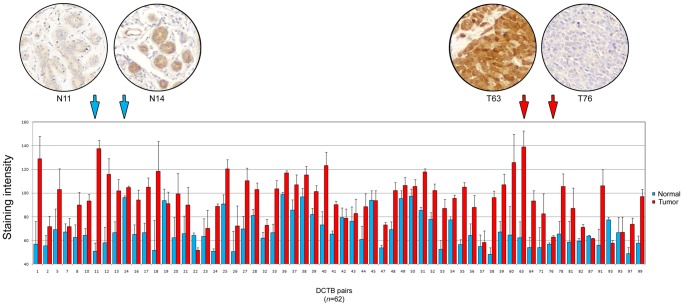
Expression analysis of BLCAP by quantitative IHC of normal specimens (blue bars) and corresponding tumor samples (red bars) of 62 matched cases from the DCTB dataset.Illustrative IHC images are shown for normal and tumor samples with weak immunoreactivity (N11 and T76, respectively), and for normal and tumor samples showing substantial immunoreactivity for BLCAP (N14 and T63, respectively). Magnification 20X.